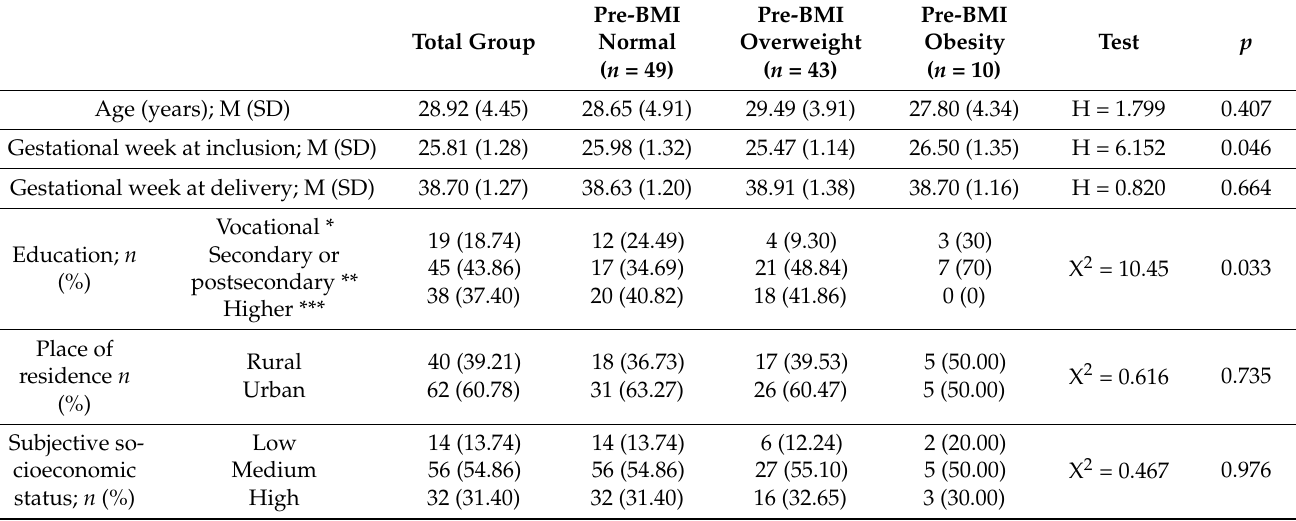
Table 1. Characteristics of the participants with gestational diabetes ( n = 102).